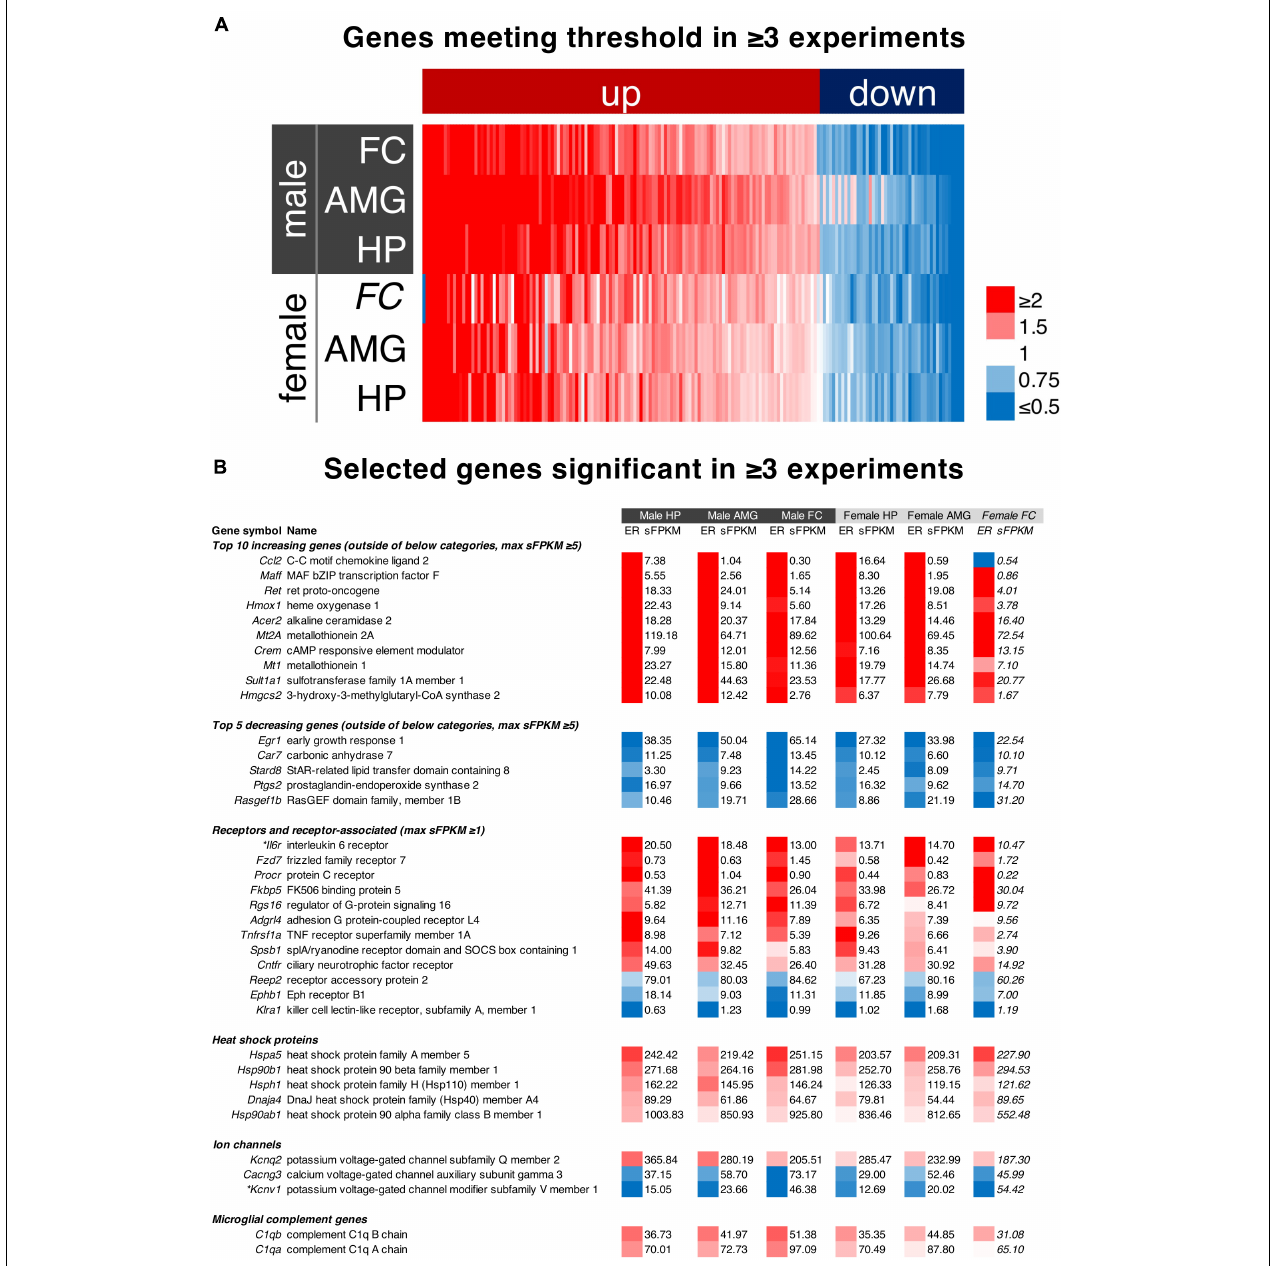
FIGURE 7 | Analysis of genes significant in at least three datasets. In order to examine the most highly significant genes across all brain regions and across sex, we selected genes with a maximum sFPKM ≥ 1 that met the significance threshold in at least three of the five datasets in which statistics were performed (177 genes total). (A) These genes were plotted as a heatmap sorted by average expression ratio across the six datasets (the female frontal cortex was included, N = 2 rats, statistics not performed). This resulted in a heatmap in which all genes were regulated uniformly across the six experiments, indicating a consistent effect in these three brain regions. (B) To focus on individual genes in this analysis, the top increasing and decreasing individual genes are highlighted, showing expression ratio (flame scale) and sFPKM values (average in all samples in the experiment shown). Additionally, groups of genes corresponding to receptor/receptor associated genes, heat shock proteins, ion channels, and microglial complement genes are shown to highlight highly expressed, consistently regulated genes important for pharmacology and neuroscience research.